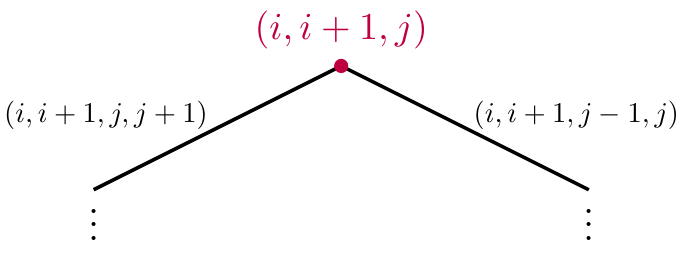
Figure 17 . The combinatoric rule of the polygon on X inherited from the cyclic geometry. An edge is given by four numbers of the form ( i; i + 1 ; j; j + 1). Two edges intersect at a vertex of the form ( i; i + 1 ; j ) if they share three numbers.